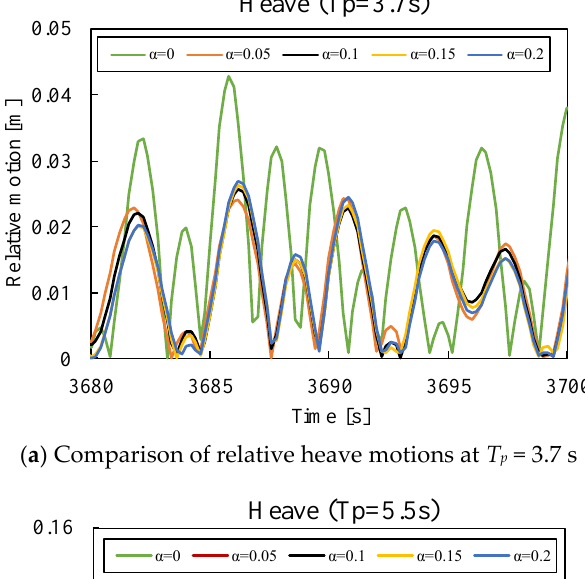
Figure 20. Layout of the mooring system for the 3-module model. On the basis of the artificial damping being introduced, the motion responses of the three-module model in irregular waves were calculated in the time domain. Under the JONSWAP spectrum, the head sea with a significant wave height of 2 m was selected. Two spectral peak periods of 5.5 s and 3.7 s are considered. Wherein, the period of 3.7 s corresponds to the resonant frequency. On the basis of the RMFC model, the dynamic response of the connector system in irregular waves was calculated in the time domain, the calculation time is 3 h. Figure 21 shows the time-domain response of relative motion between front two modules under two different periodic. It is found that when the peak period of the incident wave spectrum is close to the resonant frequency, the amplitude of motion response is greatly changed by introducing a damping lid, while it seems not sensitive to the artificial damping ratio. This can also be seen from the statistical results (Figure 22). This indicates that the time-domain motion response near the resonance pe- riod will be significantly affected by the multi-body hydrodynamic interactions and the accuracy is pretty poor without considering the artificial damping. While the relative motion between the modules under the resonant periodic wave can be significantly re- duced by introducing artificial damping, which will be helpful to the analysis of the system response and the connector load in the next section. ( a ) Comparison of relative heave motions at T p = 3.7 s ( b ) Comparison of relative pitch motions at T p = 3.7 s